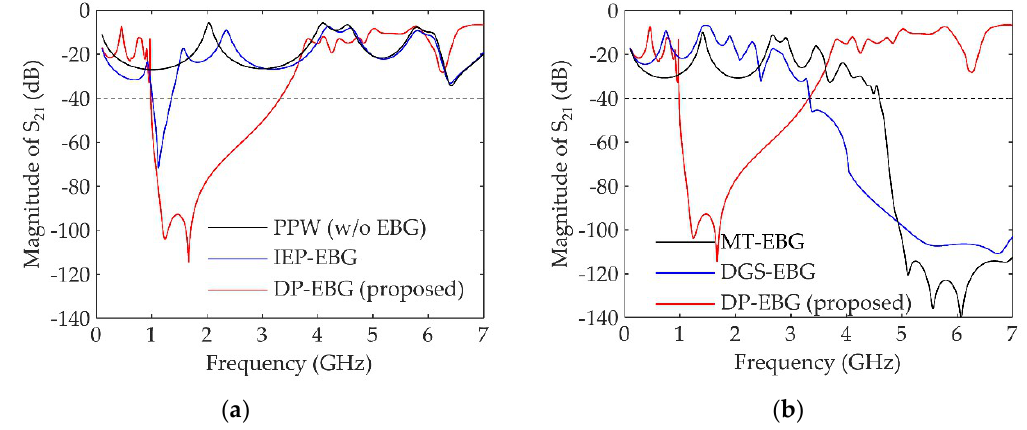
Figure 10. Comparison of S-parameters between ( a ) the ppw, IEP-EBG and proposed EBG structures and ( b ) MT-EBG, DGS-EBG, and proposed EBG structures to demonstrate a broad stopband bandwidth and miniaturization.